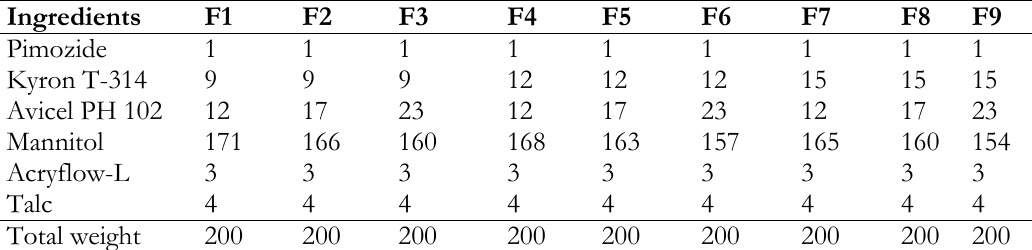
Table II. Formulation of FDTs of pimozide